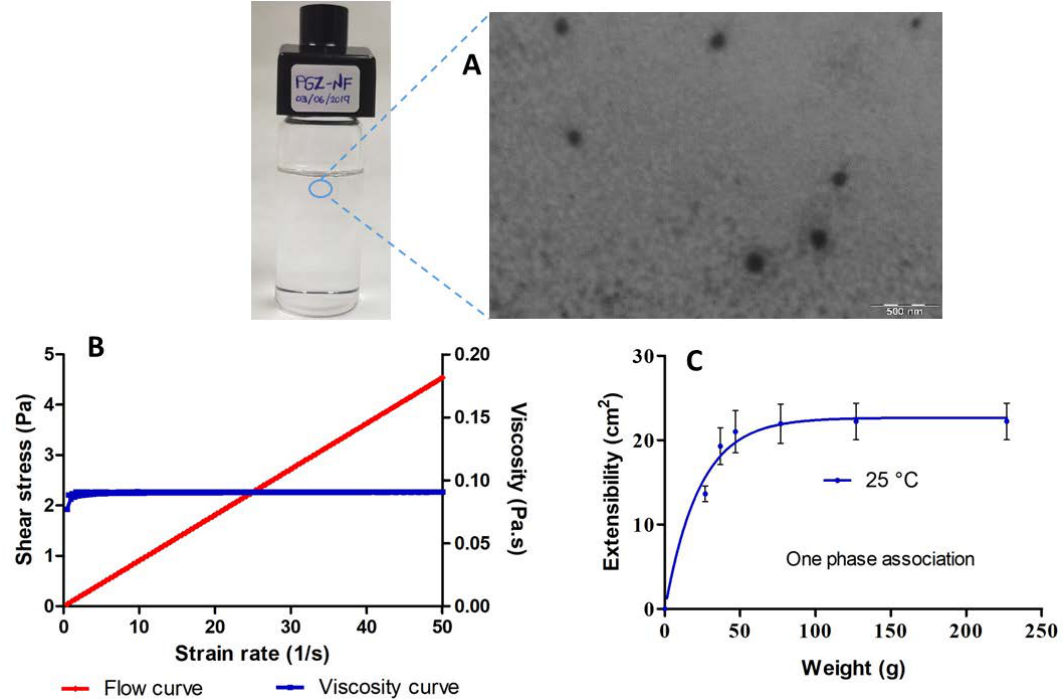
Figure 2. Characterization of pioglitazone-nanoemulsion (PGZ-NE): ( A ) transmission electron microscopy (TEM) image of PGZ-NE. Magnification 40,000 ×; ( B ) rheogram of PGZ-NE at 25 °C showing both flow and viscosity curves; and ( C ) extensibility profile of PGZ-NE at 25 °C.